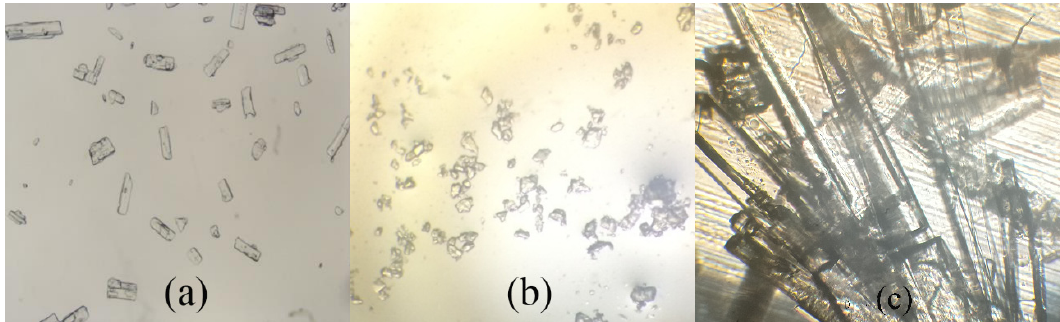
Figure 3. Micrographs of ( a ) Met (40×), ( b ) Gli (40×), ( c ) Gli ‐ Met (100×) obtained by polarized optical microscopy (POM) at room temperature.